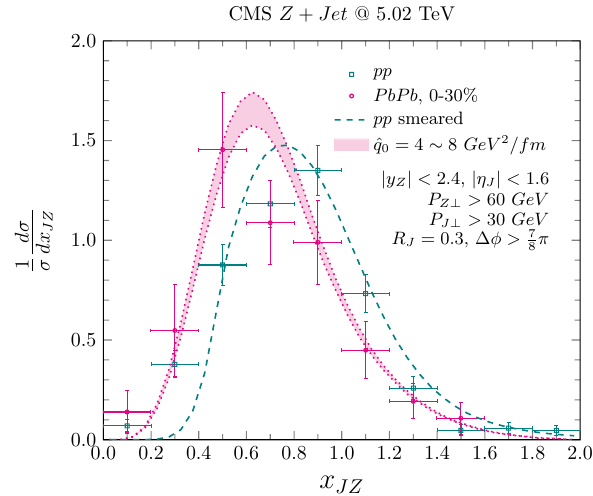
Fig. 8 Normalized smeared x JZ distribution for both pp (dashed) and central PbPb 0–30% (dotted) data at 5.02 TeV in comparison with the CMS [60] experimental data